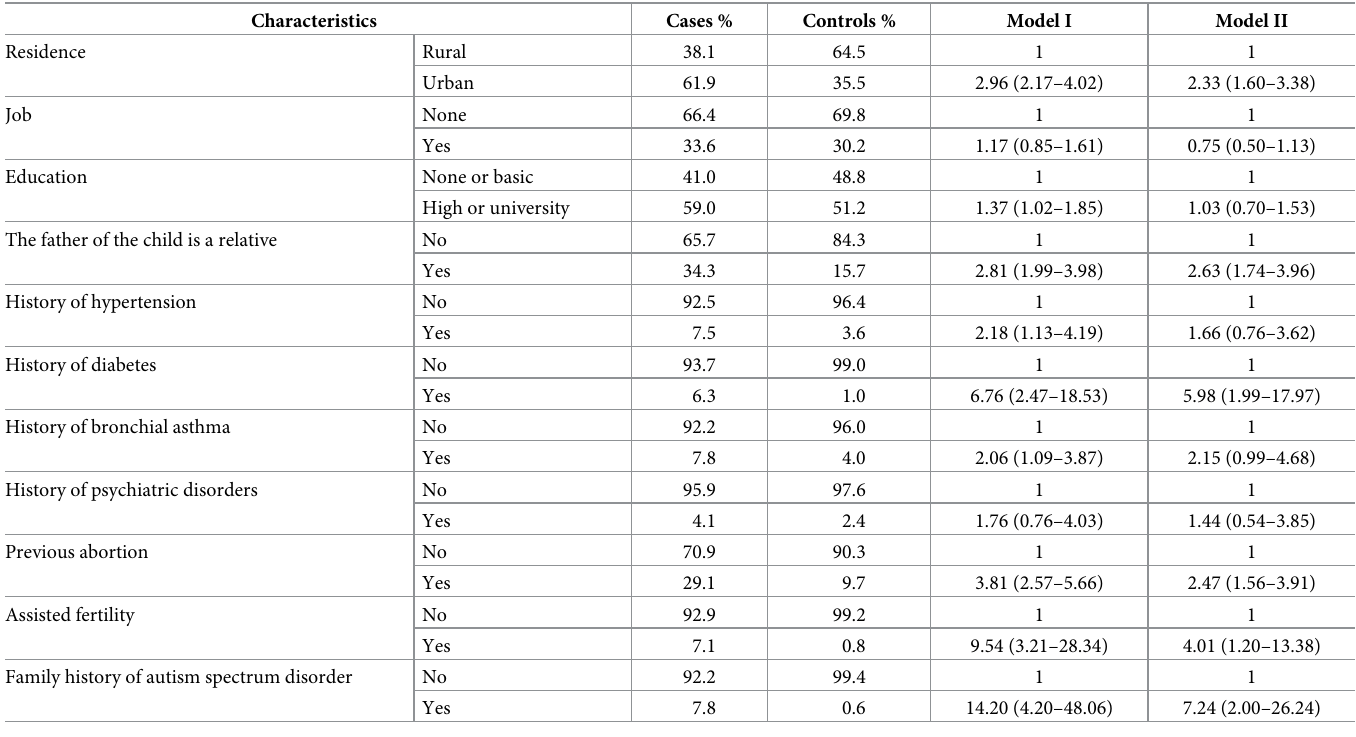
Table 2. Preconception maternal predictors of autism spectrum